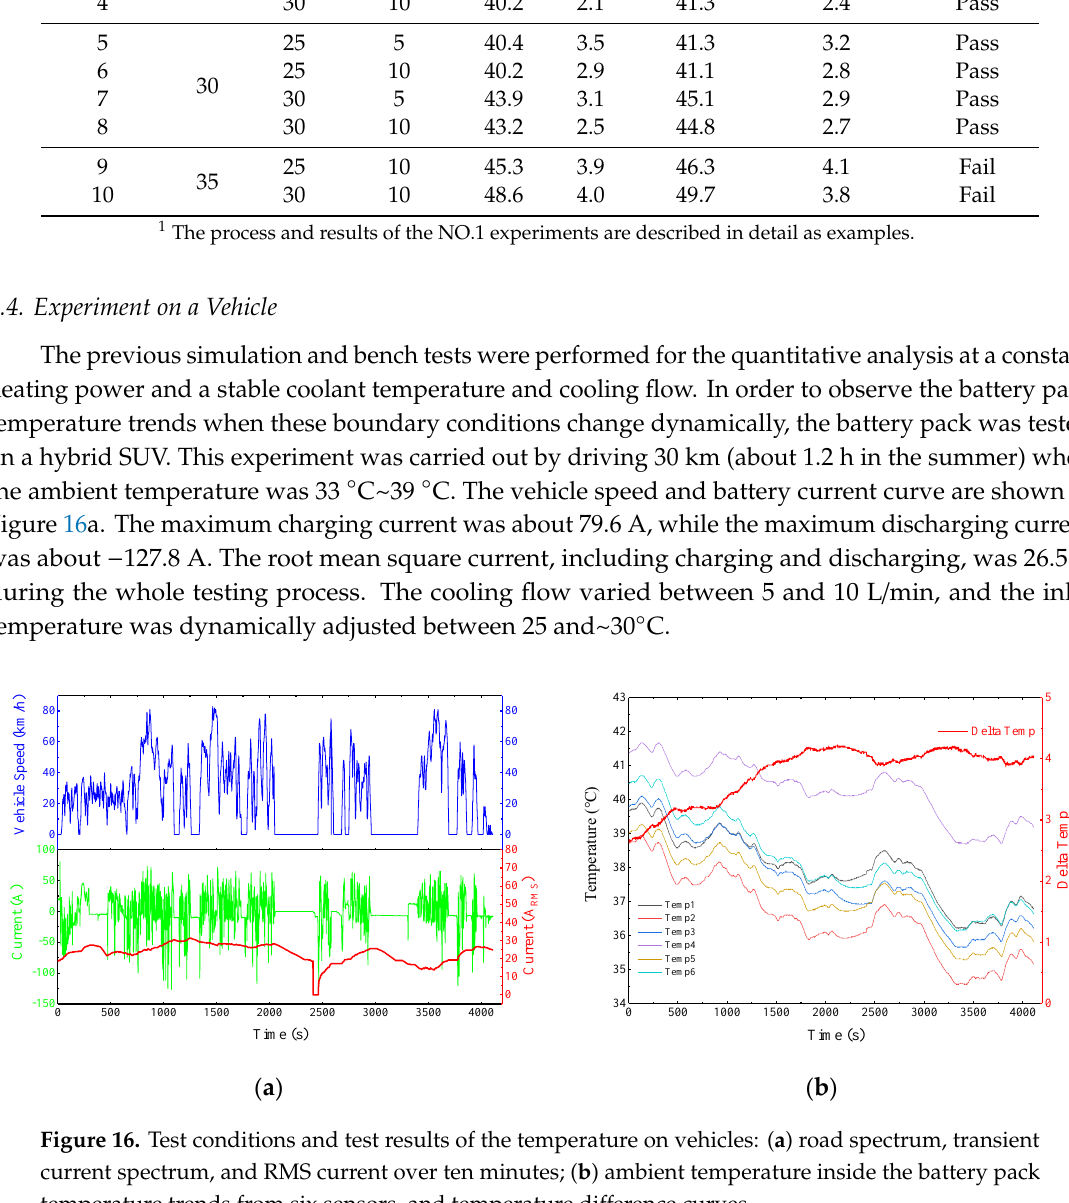
Table 6. Comparison of the experimental results and numerical results.